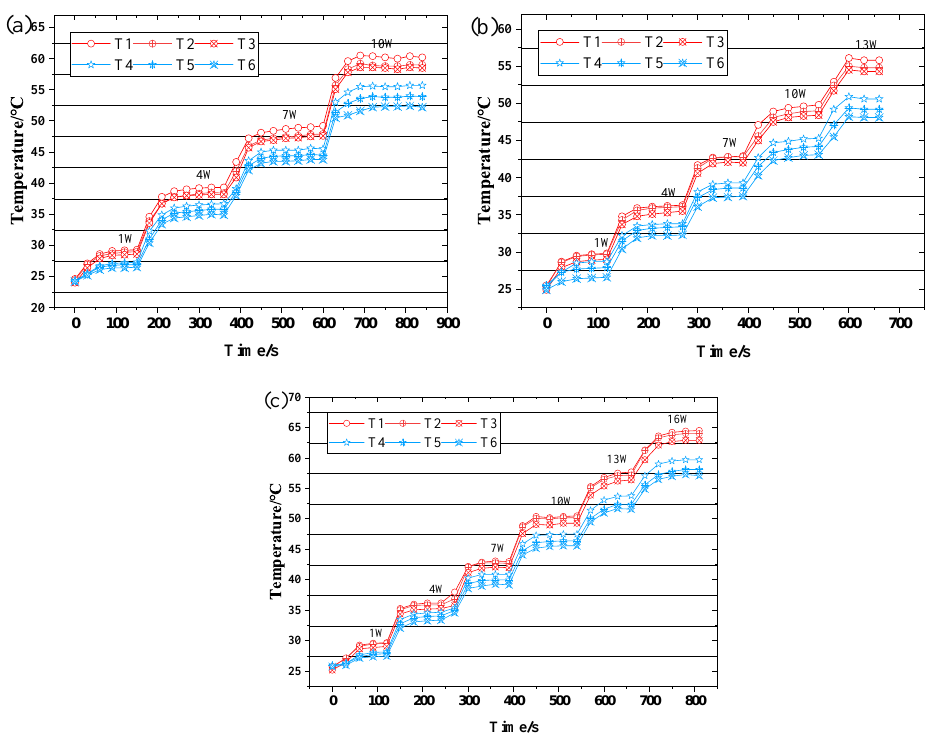
Figure 13. Dynamic characteristics of FMHP. ( a ) CFW-FMHP under 150% filling rate; ( b ) CW-FMHP under 150% filling rate; ( c ) OCW-FMHP under 140% filling rate. 3.4. Thermal Resistance The thermal resistance curves of CW-FMHP, CFW-FMHP, and OCW-FMHP under different filling rates are shown in Figure 14.